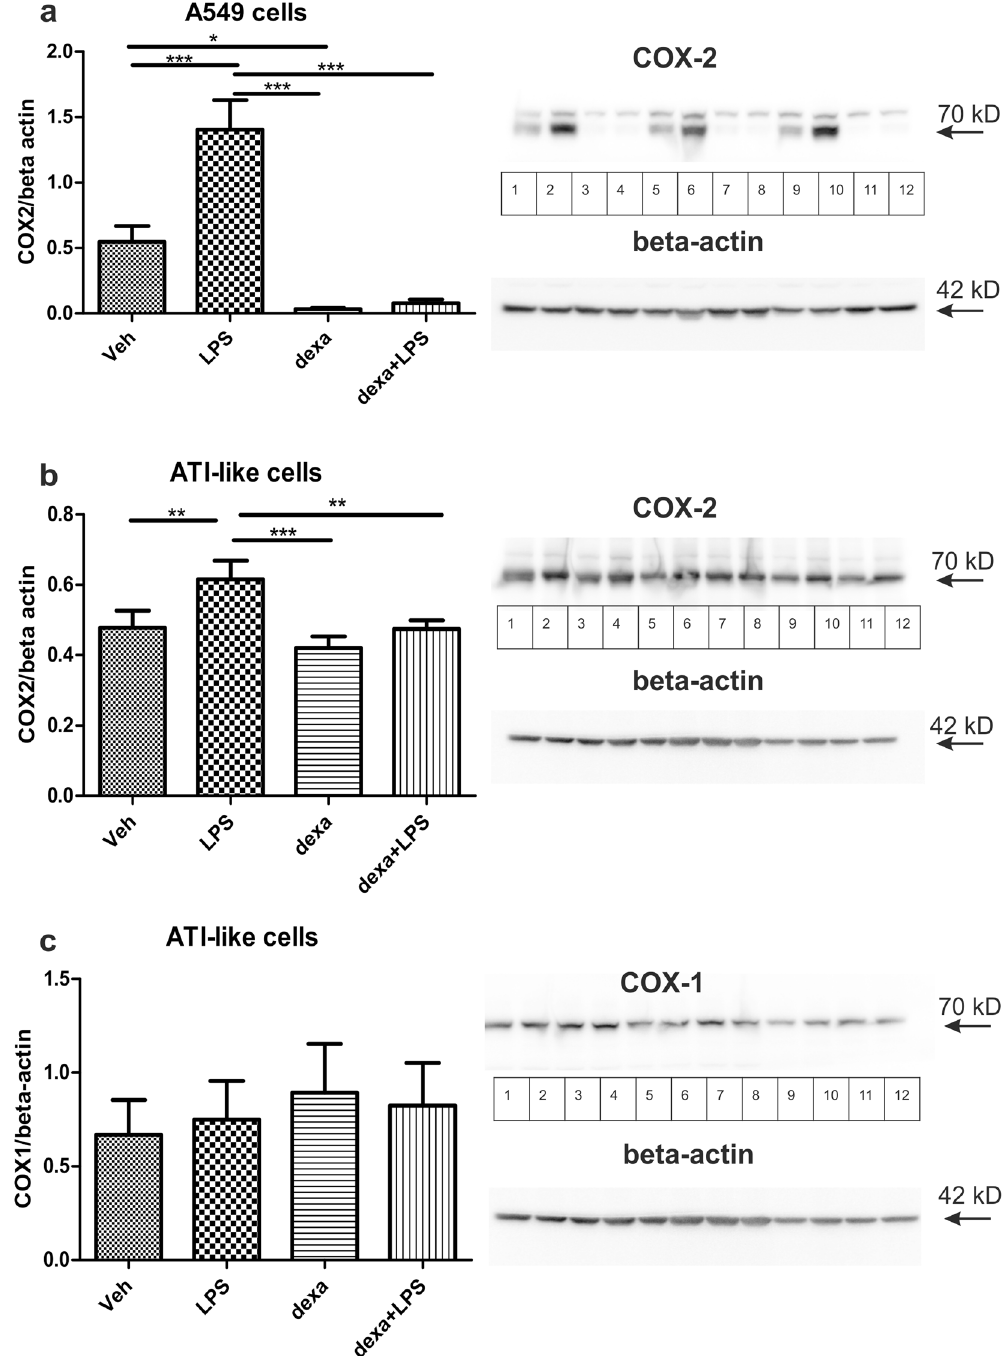
Figure 2. Primary mouse ATI-like cells express COX-2 and COX-1 and A549 cells only COX-2. ( a ) A549 or ( b , c ) mouse primary ATI-like cells were treated with vehicle (Veh), LPS (10 µ g/ml) and/or dexamethasone (dexa; 1 µ M) and ( a,b ) COX-2 or ( c ) COX-1 expression was determined by Western blot. A549 cells did not express COX-1. Densitometric values normalized to beta actin are shown as mean + SEM. Inserts on the right show sections of typical blots (lanes vehicle: 1,5,9; LPS: 2,6,10; dexamethasone: 3,7,11; LPS + dexamethasone: 4,8,12). The inserts in ( b ) and ( c ) show the same membrane and thus the same loading control was used. n = 6 for A549 cells and n = 5 for primary ATI-like cells. Statistical analysis was performed using One Way ANOVA and Bonferroni’s post-hoc test, * p < 0.05; ** p < 0.01; *** p <